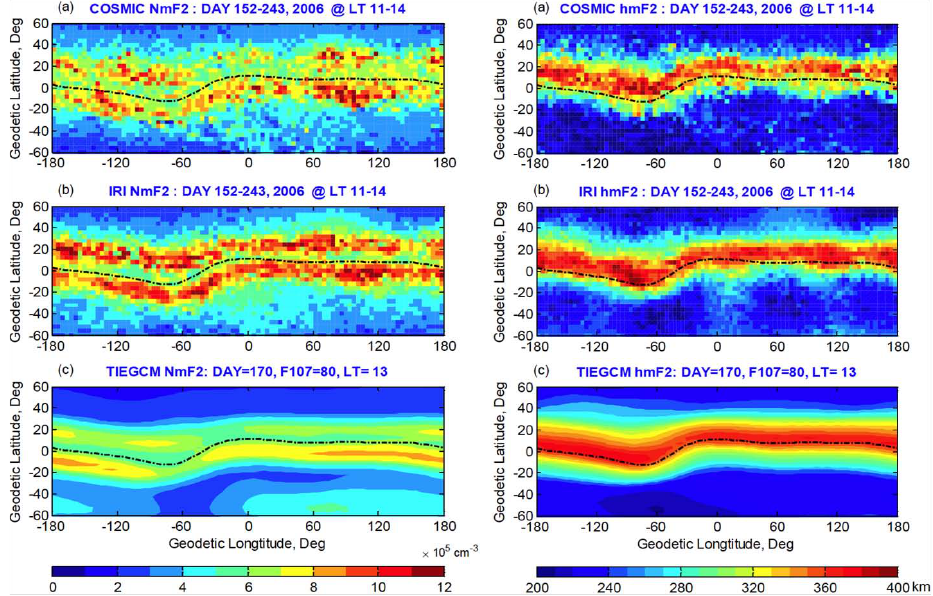
Fig. 41. Ionospheric climatology. Latitude-longitude plots of COSMIC measurements of the peak density and altitude in the equatorial ion- ization anomaly during the Northern Hemisphere summer (days 152–243) 2006 compared to: an empirical model (International 40. Refer- ence Ionosphere) (IRI) and a numerical model (NCAR Thermosphere-Ionosphere-Electrodynamics General Circulation Model) (TIEGCM). Left panels: NmF2 from COSMIC (top), IRI (middle) and TIEGCM (bottom). Right side: hmF2 from COSMIC (top), IRI (middle) and TIEGCM (bottom) (Lei et al., 2007).